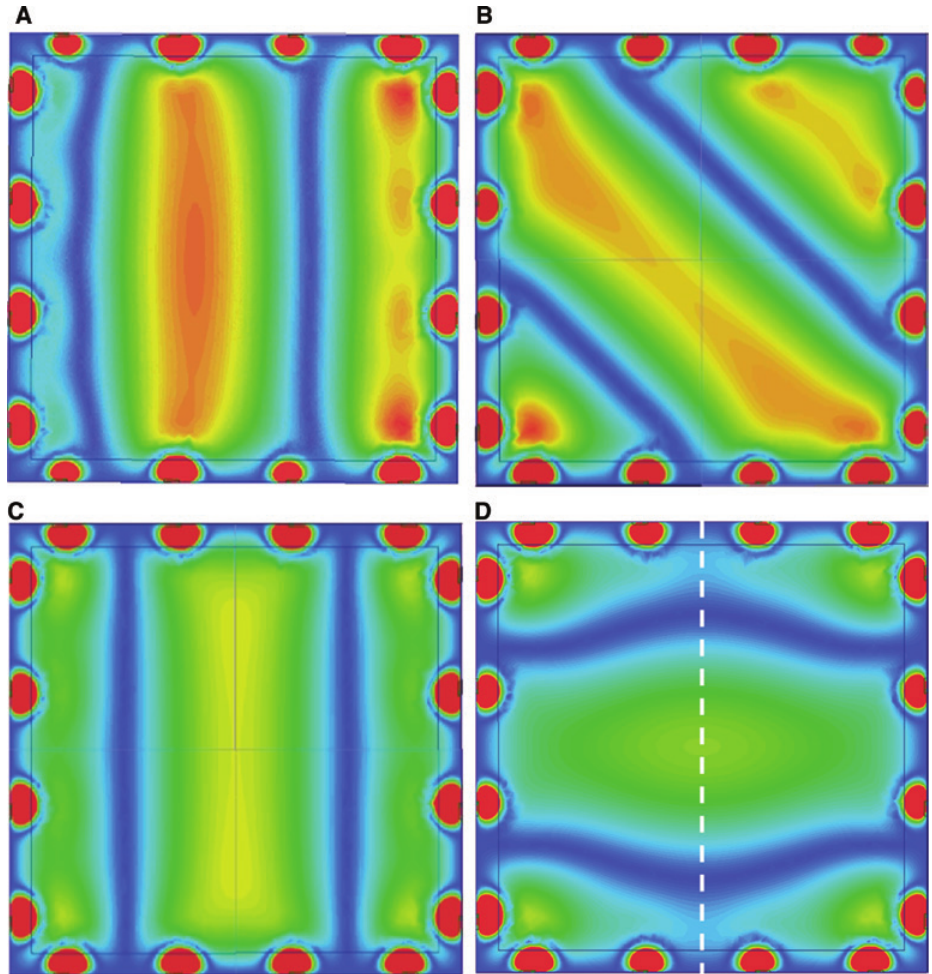
Figure 26: Fullwave simulation results for arbitrary wavefront generation using an active HMS. (A) A travelling wave in the horizontal direction (obtained from [150]); (B) a travelling wave in the diagonal direction, 45 ° from the horizontal ( x -) axis (obtained from [150]); (C) a standing wave in the x -direction, with electric field maxima very close to the metallic side walls (obtained from [150]); and (D) a superoscillation wave with a subwavelength focus at the image plane y = 0 (denoted by the white dashed line). Obtained from [150]. For subfigures (A) and (B), the real part of the electric field phasor is plotted; for subfigures (C) and (D), the electric field phasor amplitude is